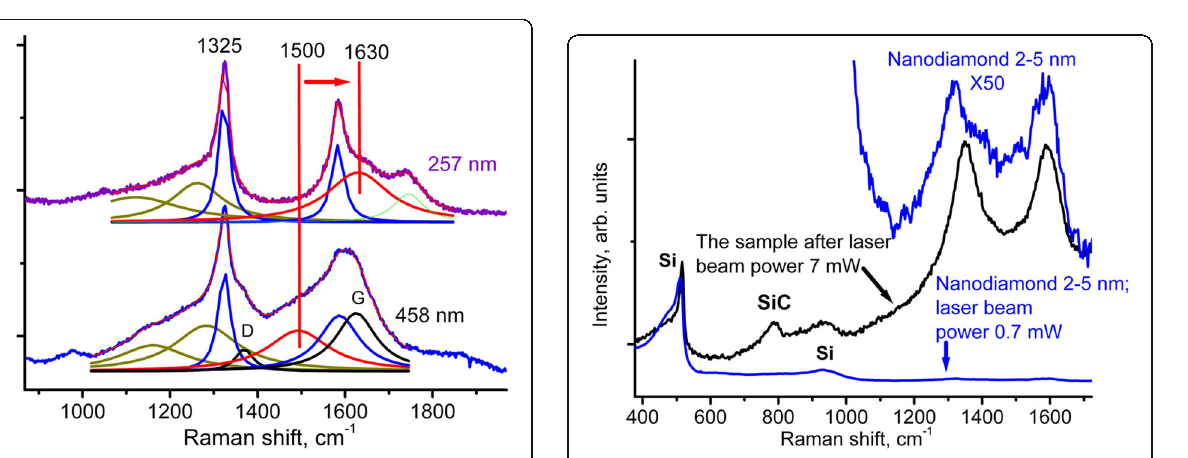
Fig. 4 Raman spectra of the 2 – 5-nm nanodiamond mixed with Si (the bottom spectrum) and created after high-power irradiation sp 2 clusters (the middle spectrum). The upper spectrum appropriates to the bottom spectrum with the intensity multiplied by the factor of 50. Bands related to Si (the first and the second orders) and SiC (around 790 cm − 1 ) are marked. The spectra were acquired at the same 0.7 mW laser beam power. Excitation wavelength was 532